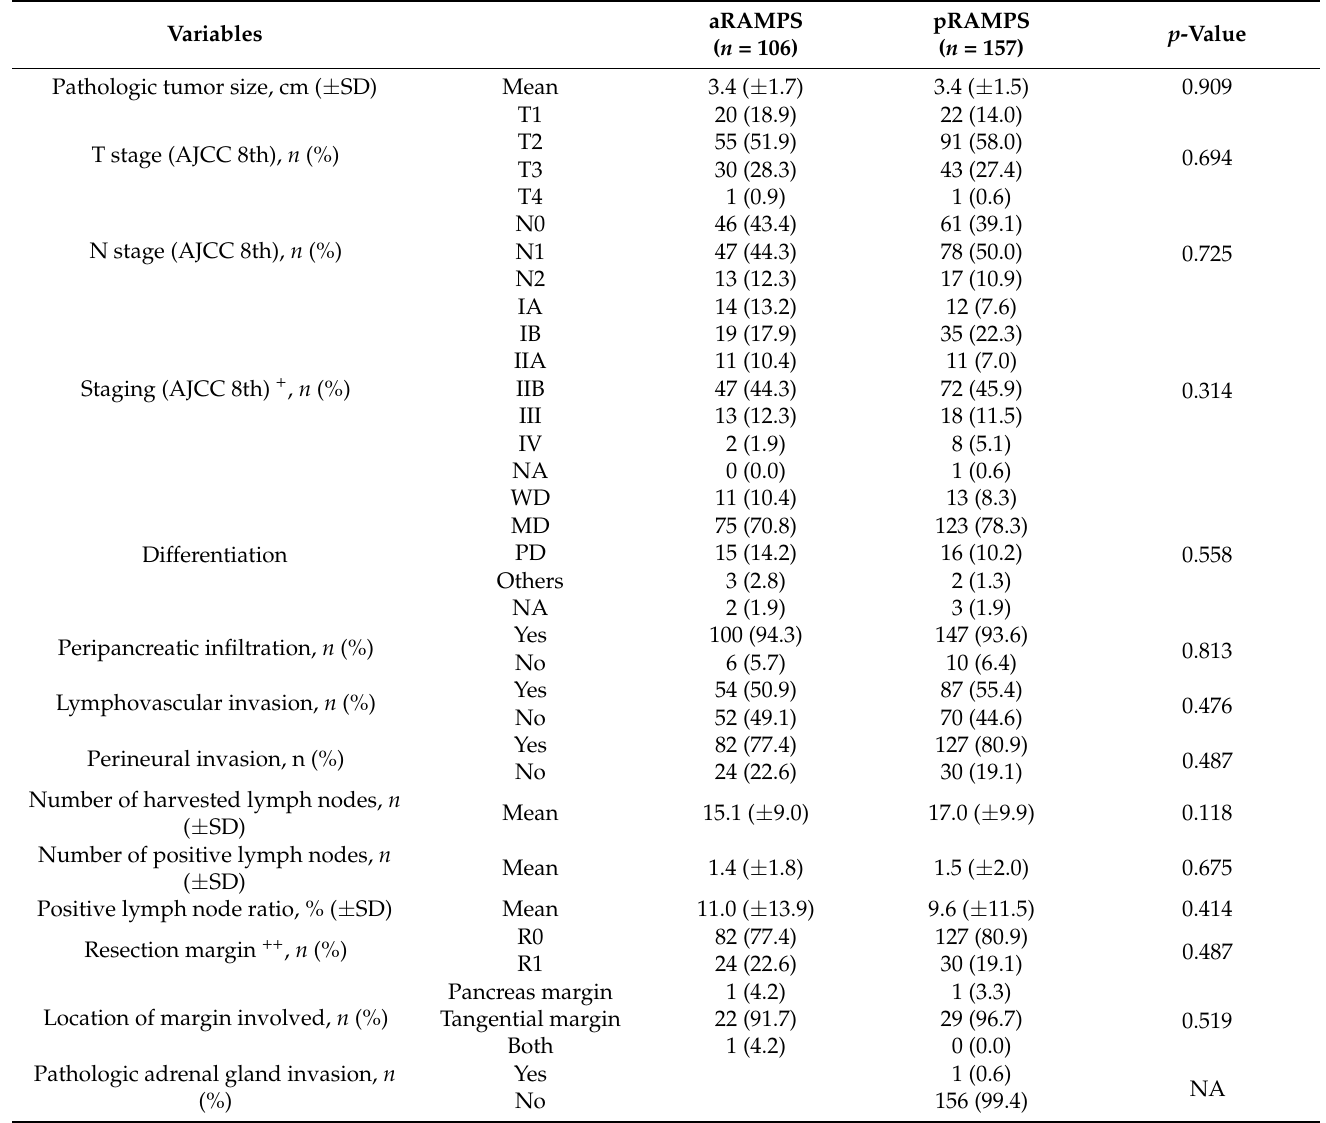
Table 6. Pathologic outcomes of radical antegrade modular pancreatosplenectomy among patients without periadrenal